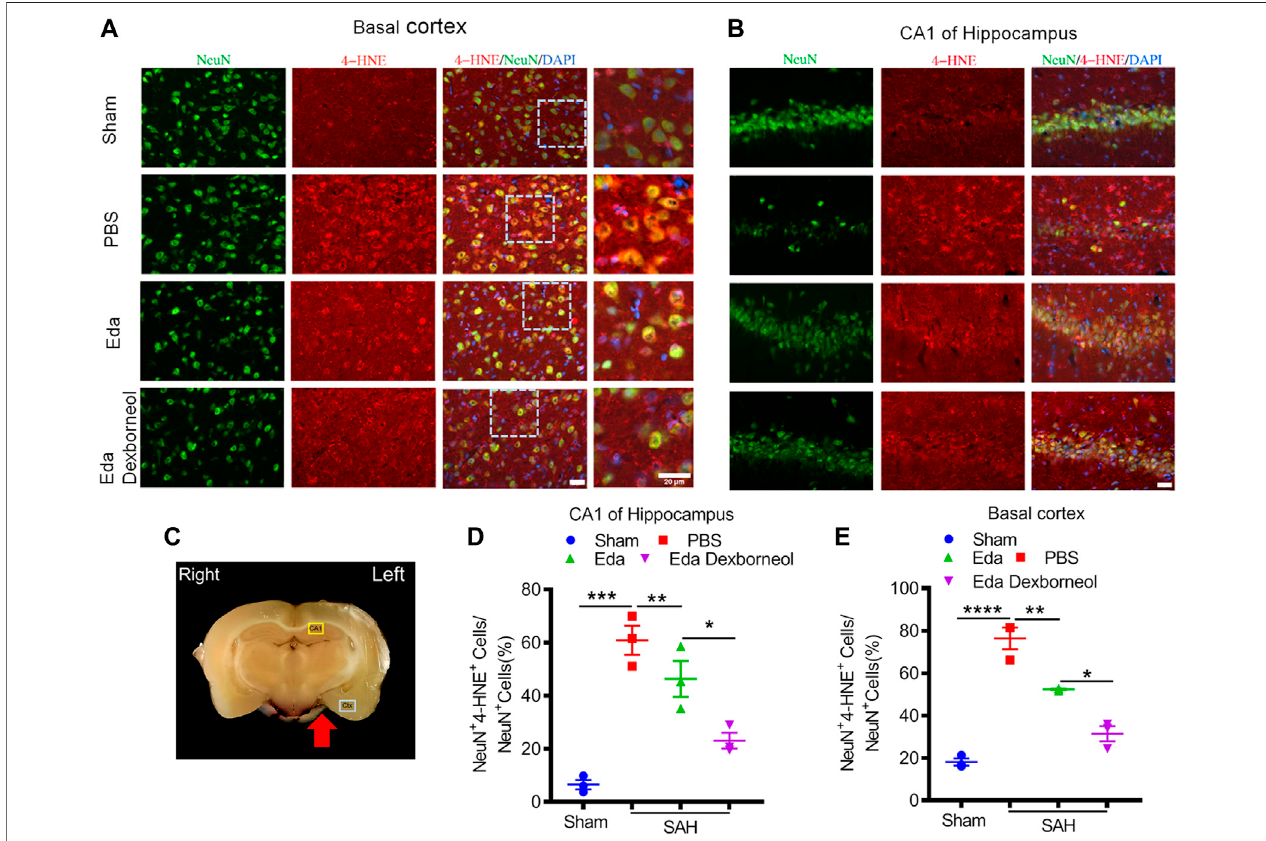
FIGURE 6 | Edaravone dexborneol treatment decreases the levels of 4-HNE in neurons after SAH injury. (A,B) Representative immuno fl uorescence images of 4- HNE (red)/NeuN (green)-stained neurons in the basal cortex (A) and CA1 of the hippocampus (B) at 3 d after SAH. Scale bar: 20 µm. (C) The schema illustrates the regionsofinterestrelated to fl uorescence staininginthebraincortexorhippocampus. (D,E) Quantitative analysisof4-HNE +neuronsinthebasalcortex (D) and CA1of the hippocampus (E) at 3 d after SAH. n = 3/group. Data are given as mean ± SE. * p < 0.05, ** p < 0.01, *** p < 0.001, **** p < 0.0001. Eda: edaravone; Eda dexborneol: edaravone